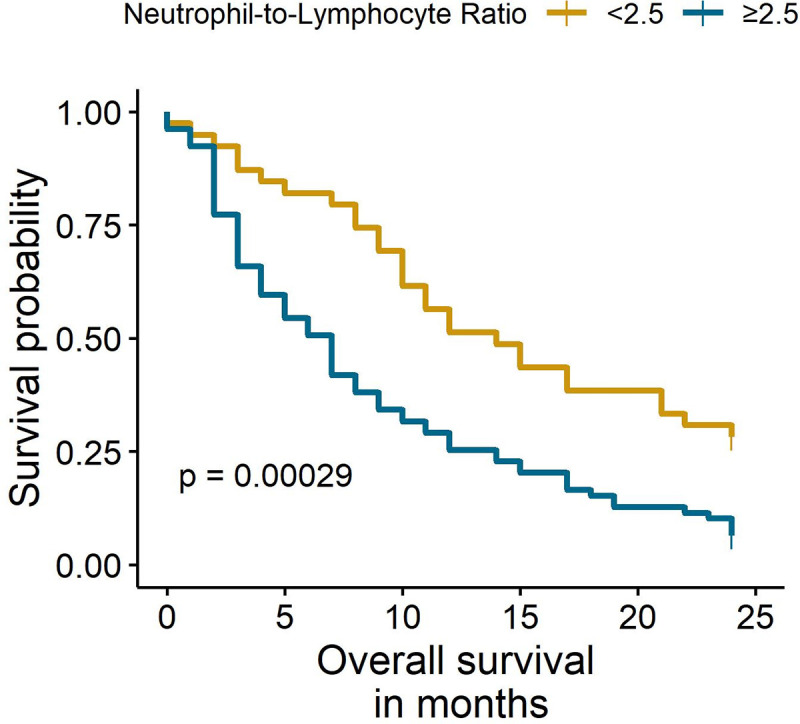
Overall survival of total females according to NLR status.